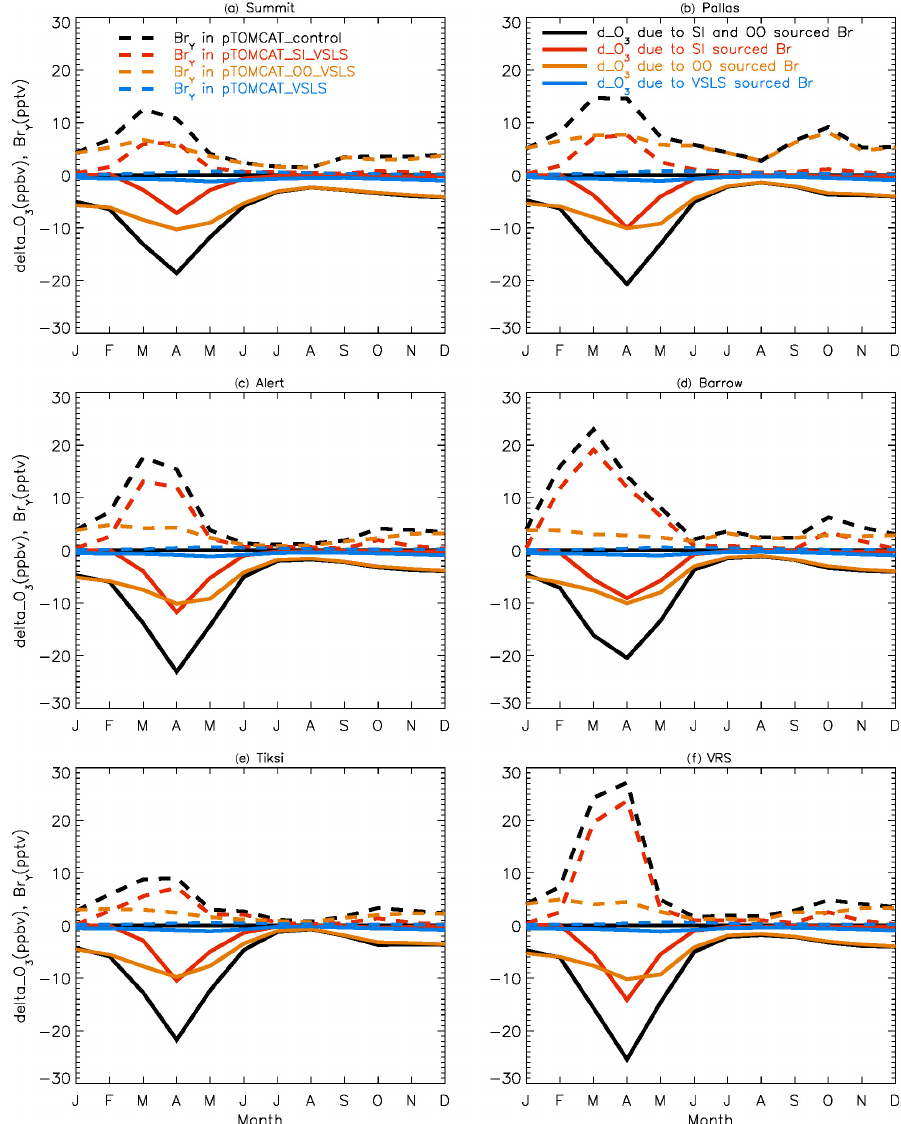
Figure 3. Ozone changes in response to alteration of various bromine sources. E.g. solid black line = pTOMCAT_control – pTOM- CAT_VSLS, representing both SI and OO contributions; solid red line = pTOMCAT_control – pTOMCAT_OO_VSLS, representing SI contribution only; solid orange line = pTOMCAT_control – pTOMCAT_SI_VSLS, representing OO contribution only; and solid blue line = pTOMCAT_VSLS – pTOMCAT_No_Br, representing VSLS contribution only. Dashed lines represent total inorganic bromine (Br Y ) in var- ious model runs: the dashed black line is the pTOMCAT_control run, representing all bromine source contributions; the dashed red line is the pTOMCAT_SI_VSLS run, representing SI and VSLS contributions; the dashed orange line is the pTOMCAT_OO_VLSL run, representing OO and VSLS contributions; and the dashed blue line is the pTOMCAT_VSLS run, representing VSLS contribution